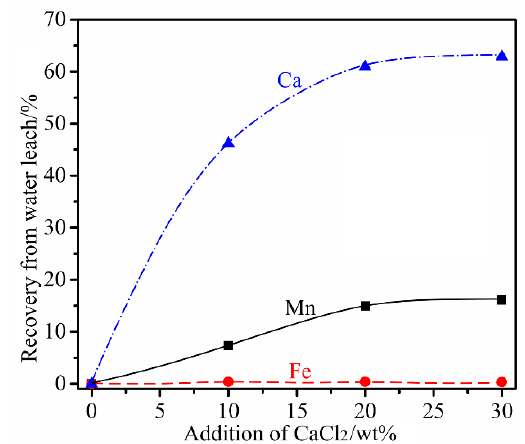
Figure 7. Recovery rates of elements by water-leaching the solid products vs. the addition of various amounts of CaCl 2 before carbothermic reduction.